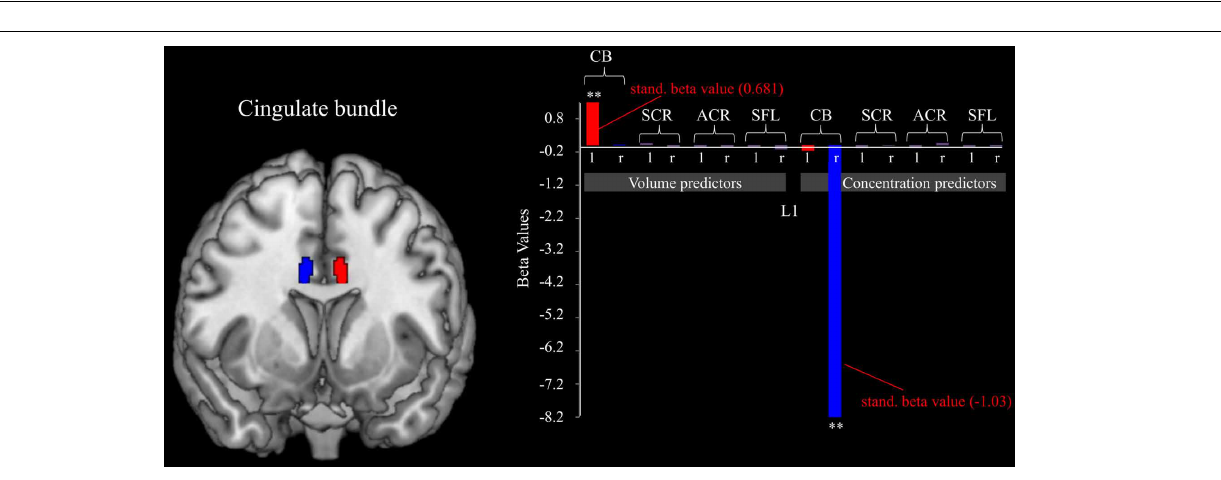
MCC contributes strongly to training success as is shown by the significant ( ∗∗ p < 0 . 001) beta value, whereas all other brain structures show a negligible relationship. For significant predictors, standardized beta values are included as well.